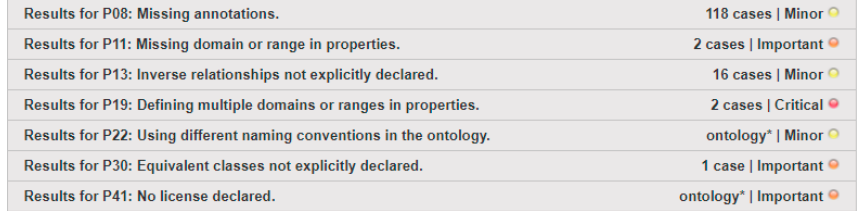
Figure 6. An excerpt from the critical pitfall.